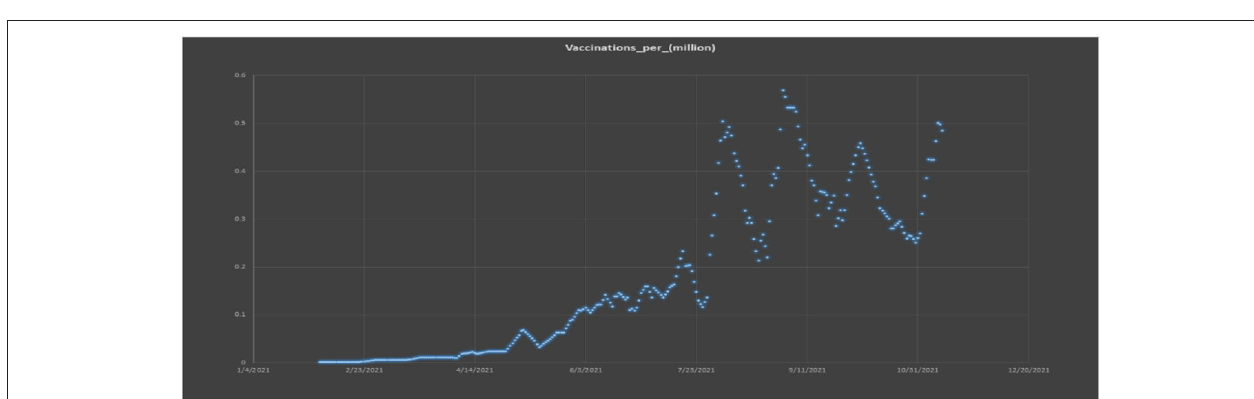
FIGURE 9 | Percentage variation of SIER model parameter.